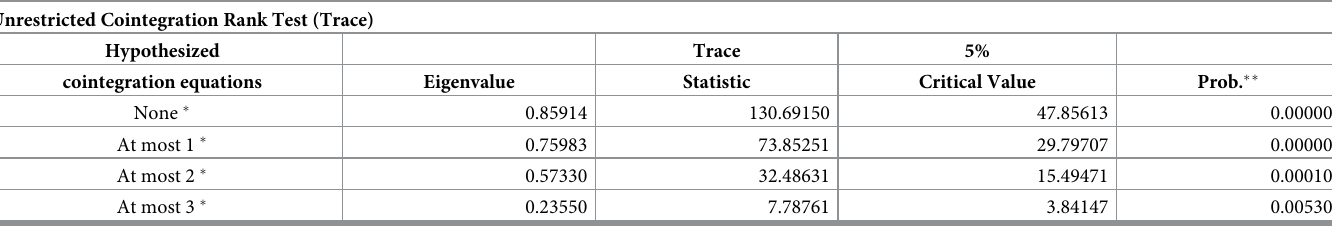
The coefficient matrix of the VEC model is shown in Table 5. Table 3. Johansen test